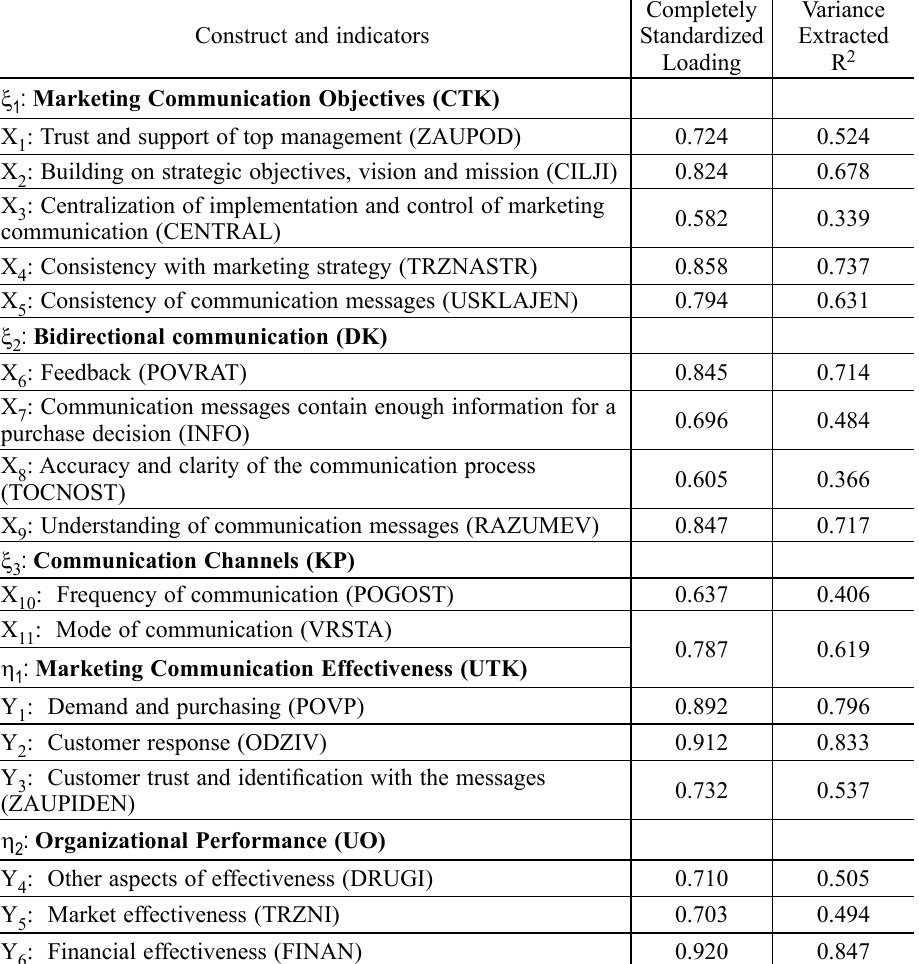
Table 3. Standardized Solutions for the Measurement Model (n =